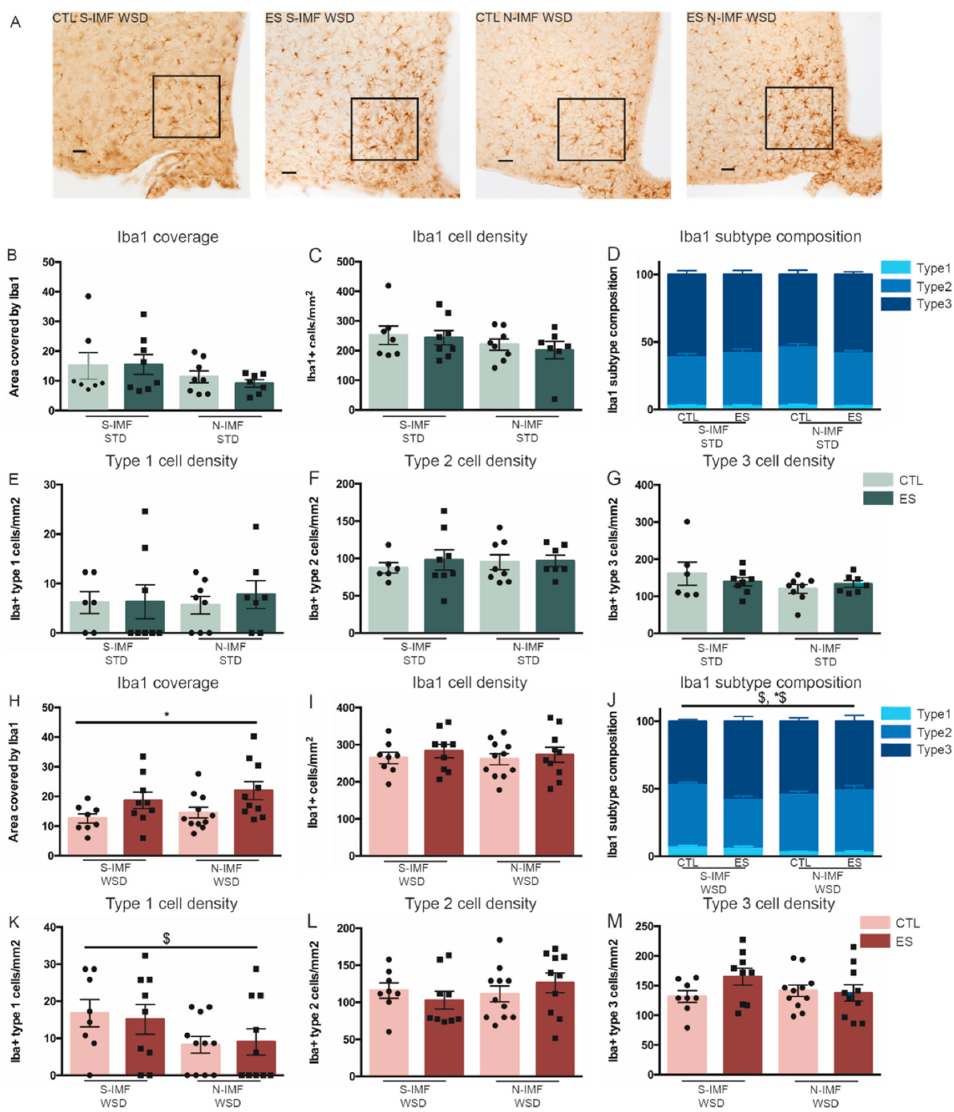
Figure 8. Effects of ES and postnatal diet on hypothalamic microglia at P230, when fed STD ( B – G ) or WSD ( H – M ) in adulthood. ( A ) representative images of Iba1 positive cells in the ARH of animals exposed to WSD. ( B – G ) On standard adult diet, ES nor postnatal diet affected hypothalamic microglia coverage, density or subtype composition (for different subtypes see Figures 3B and 6B). ( H ) On WSD, ES exposure increased Iba1 coverage ( I ) On WSD, ES and postnatal diet did not affect Iba1 cell density. ( J ) Microglia subtype composition was affected by postnatal diet and ES in animals on WSD (%type 1 diet effect; %type 2 and %type 3 diet*condition effect). ( K – M ) Type 1 density was decreased by postnatal N-IMF diet. Data are presented as mean ± SEM; scale bars 100 μ m; * condition effect; $ postnatal diet effect; *$ condition by postnatal diet effect; p < 0.05.